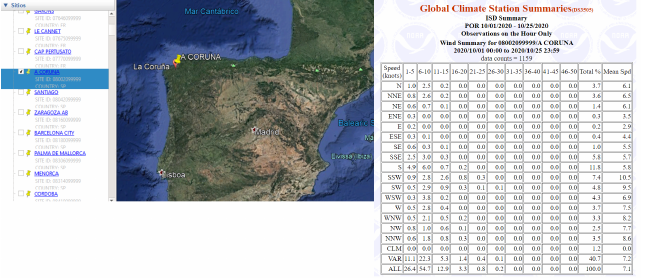
Figure 12. NOAA: Classified wind speed (A Coruña (Spain) airport). Own elaboration.